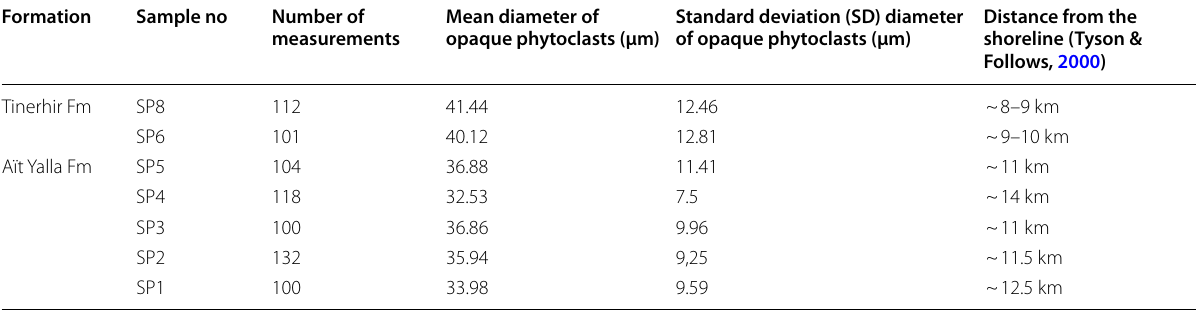
Assessments of transport distances of the opaque phytoclasts from the shoreline, according to the method of Tyson & Follows (2000), are also shown